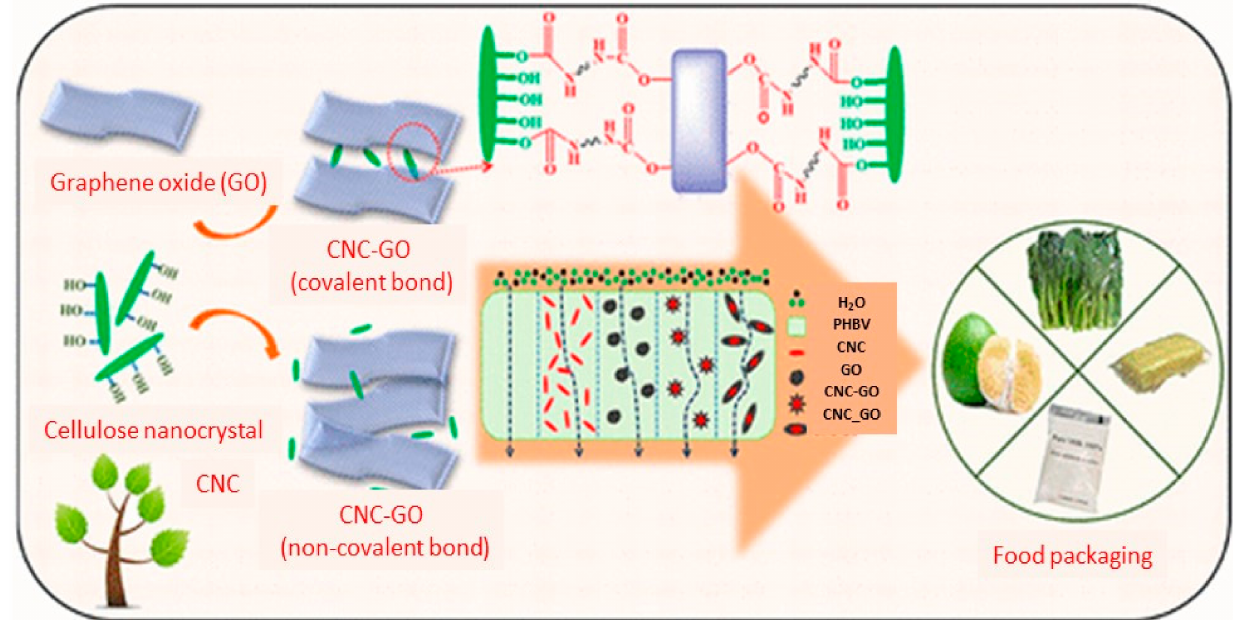
Figure 7. Schematic representation of the interactions between GO and cellulose nanocrystals via covalent and non-covalent bonds. Reprinted with permission from ref. [84]. Copyright 2019 American Chemical